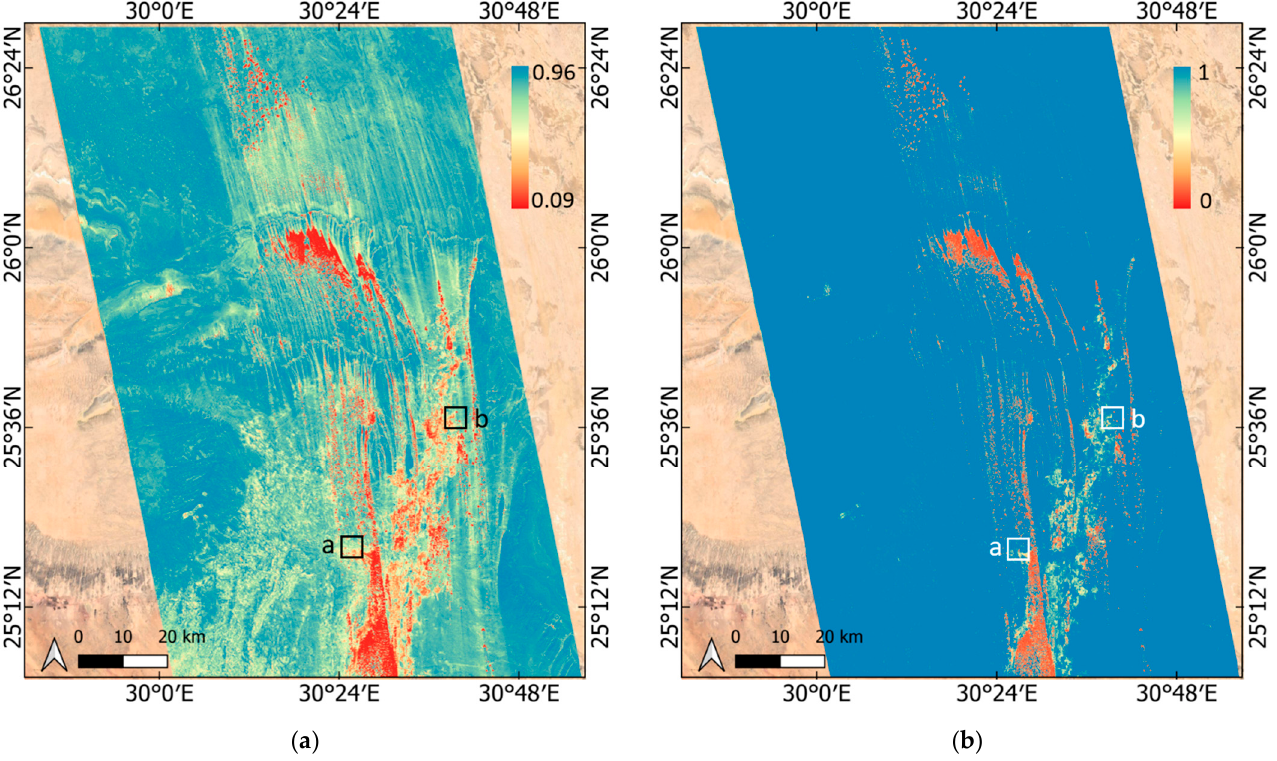
Figure 9. Mean Short-Term Coherence (MSTC) ( a ) and Temporal Stability Index (TSI) ( b ) maps computed for the Egypt use case. Both the images highlight the high stability of the scene and very few low coherence areas. Basemap: © Google 2019 Copyright.